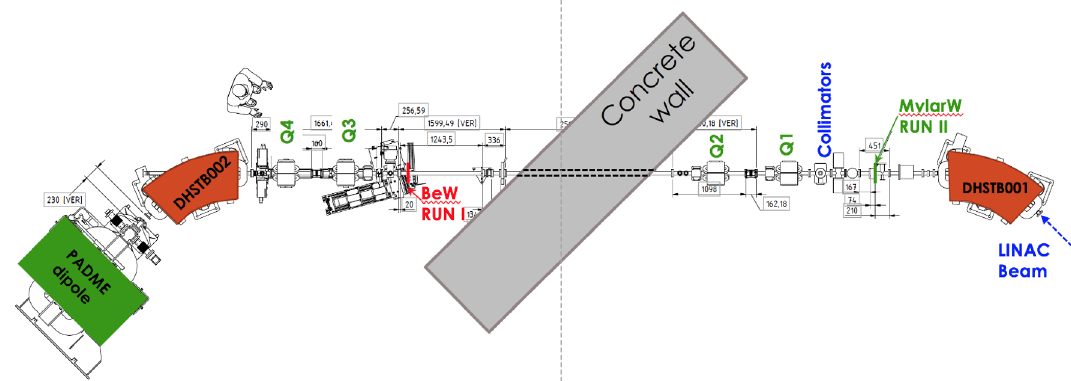
Figure 2 . Drawing of the PADME beam line setup during Run II in 2020. Quoted dimensions are in mm.